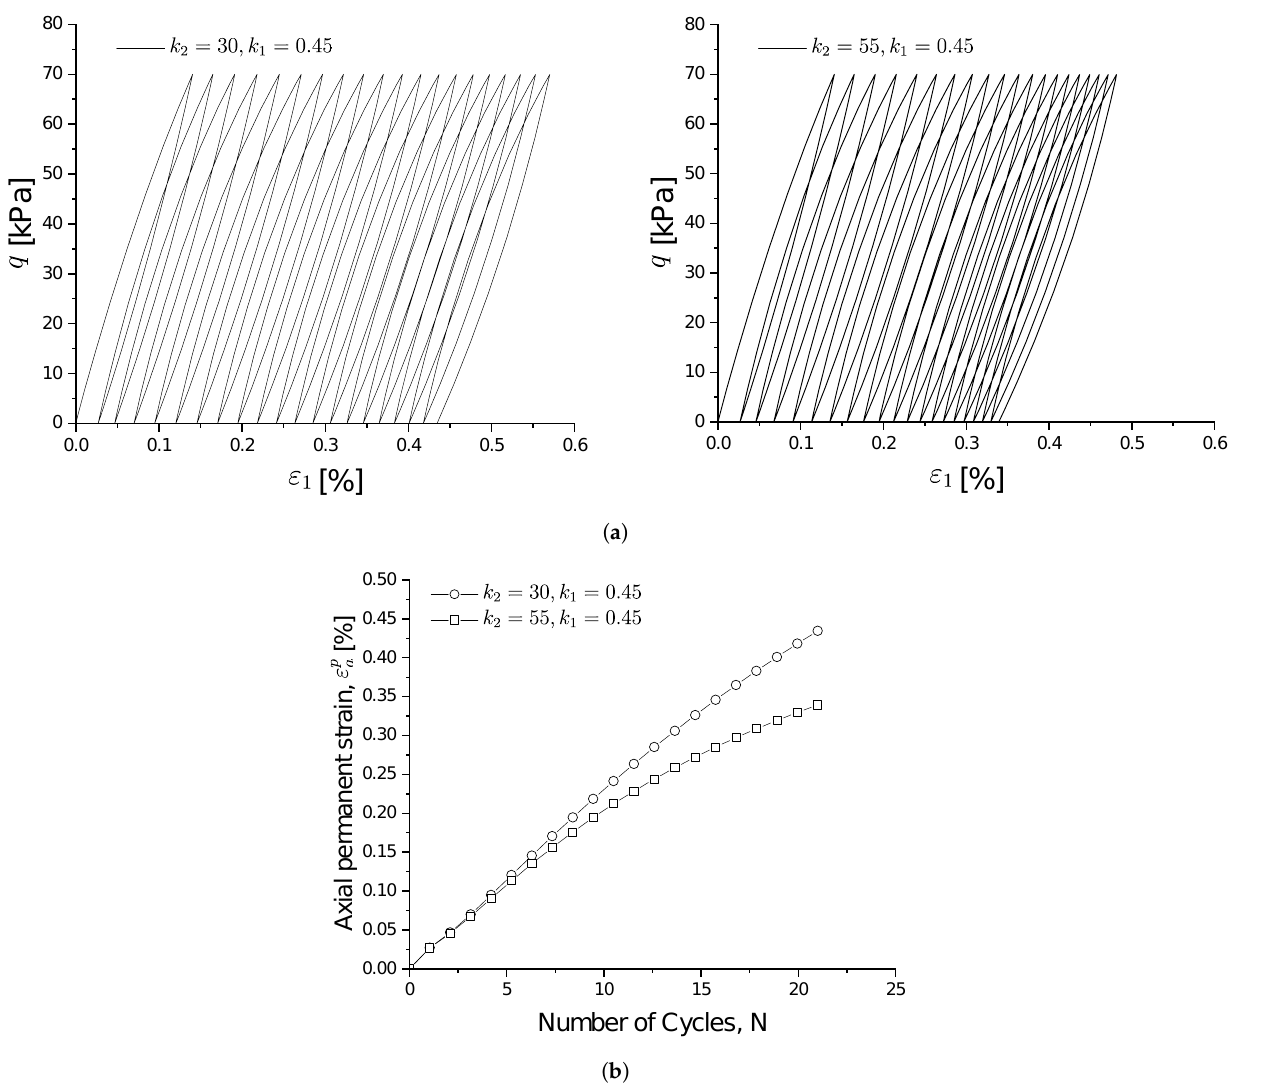
Figure 8. Influence of parameter k 2 on the cyclic stress-strain relationship ( a ) and on the permanent strain under cyclic loading ( b